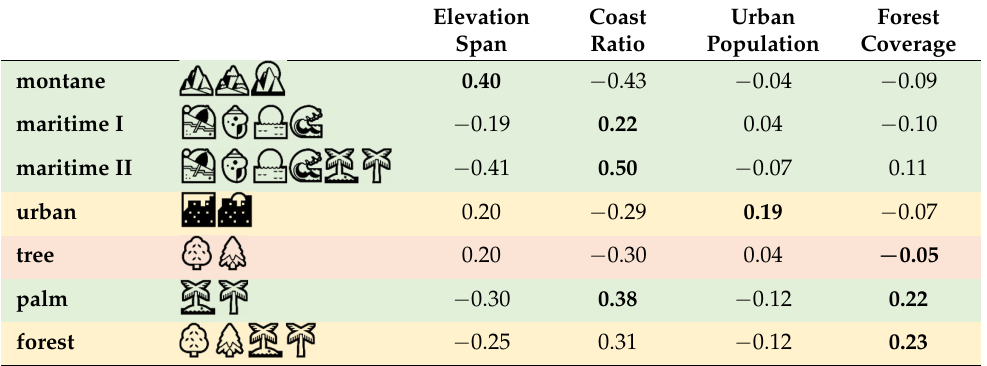
Table 1. Correlation between the typicality of environmental groups of location-specific emojis within each country and the four geographical attributes (bold: respective representative geographical attribute; green: correlation coefficient for representative geographical attribute is positive and the maximum; yellow: correlation coefficient for representative geographical attribute is positive, but not the maximum; red: correlation coefficient for representative geographical attribute is negative). Elevation Coast Urban Forest Span Ratio Population Coverage montane 0.40 − 0.43 − 0.04 − 0.09 maritime I − 0.19 0.22 0.04 − 0.10 maritime II − 0.41 0.50 − 0.07 0.11 urban 0.20 − 0.29 0.19 − 0.07 tree 0.20 − 0.30 0.04 − 0.05 palm − 0.30 0.38 − 0.12 0.22 forest − 0.25 0.31 − 0.12